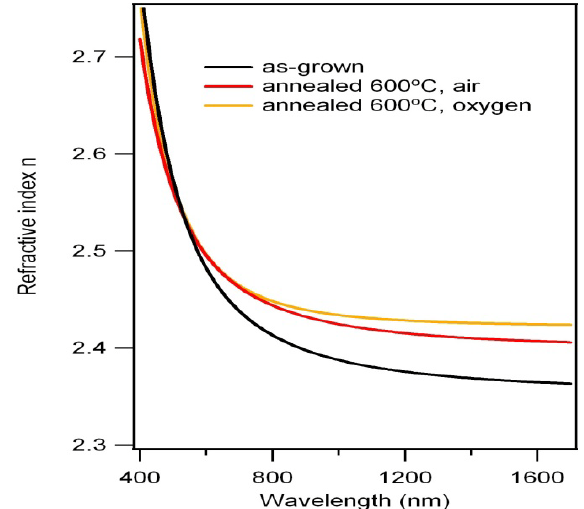
Figure 5. Best fit for the n spectra obtained for the three films using an isotropic model; analysis range 20°–60° and 300–1700